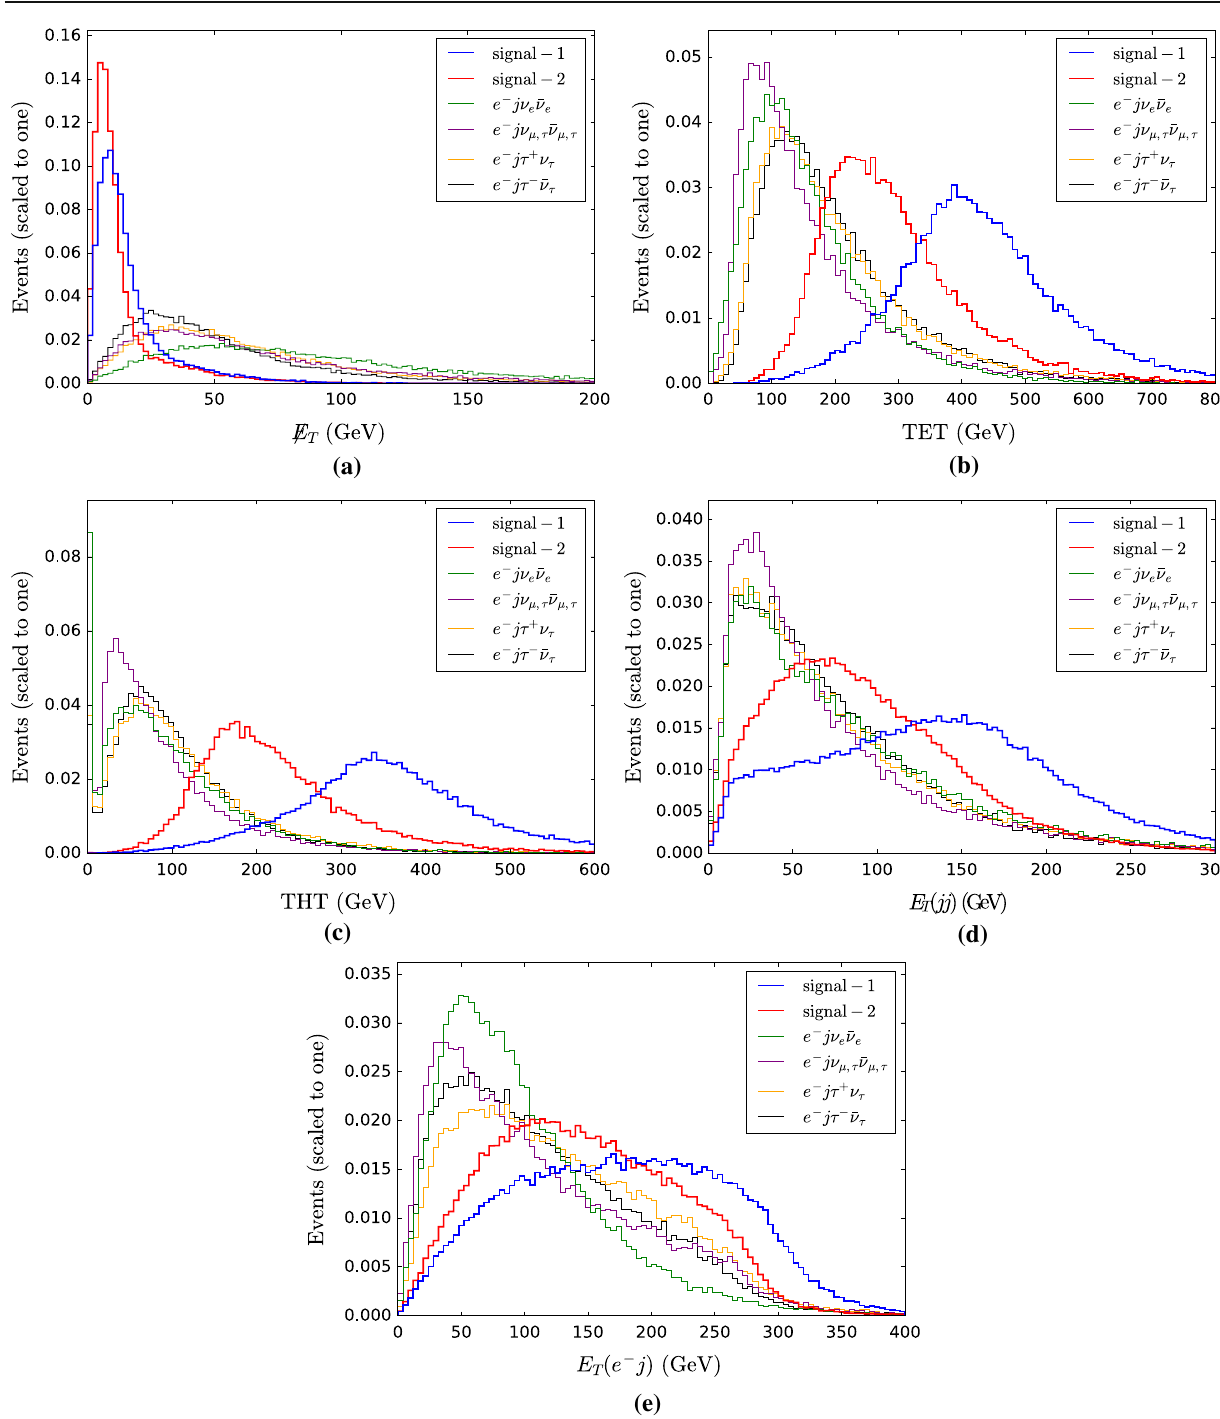
Fig. 6 Normalized distributions of (cid:3) E ( a ), TET ( b ), THT ( c ), E T ( jj ) ( d ) and E T ( e − j ) ( e ) for the signals and backgrounds at the LHeC with T E e − = 140 GeV and an integrated luminosity of 1 ab −